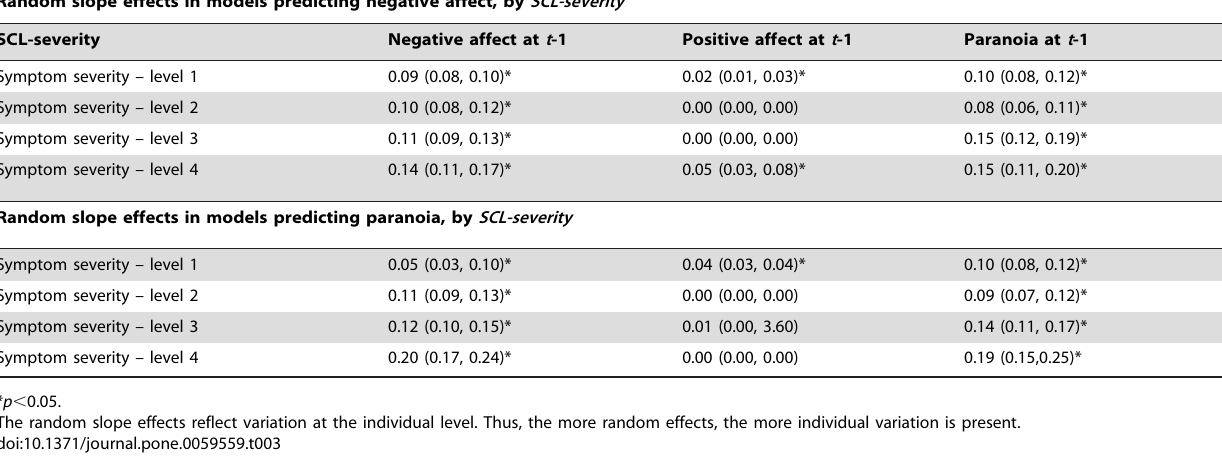
Table 3. Random slope effects in models predicting negative affect and paranoia, by